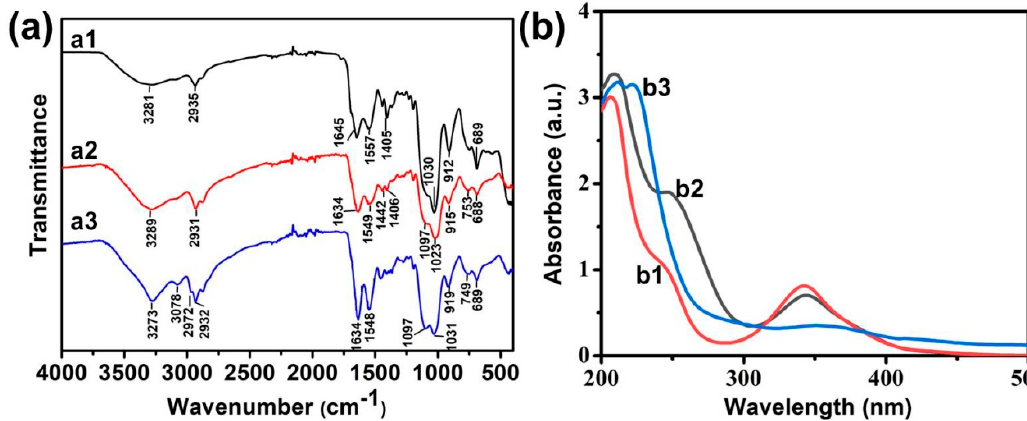
Figure 2. ( a ) FT-IR spectroscopy of Si NCs (a1), Si NCs-FA (a2), Si NCs-FA-PNIPAAm (a3); ( b ) UV-vis spectra of Si NCs (b1), Si NCs-FA (b2), Si NCs-FA–PNIPAAm (b3), the concentration of them was 5 μ g/mL.